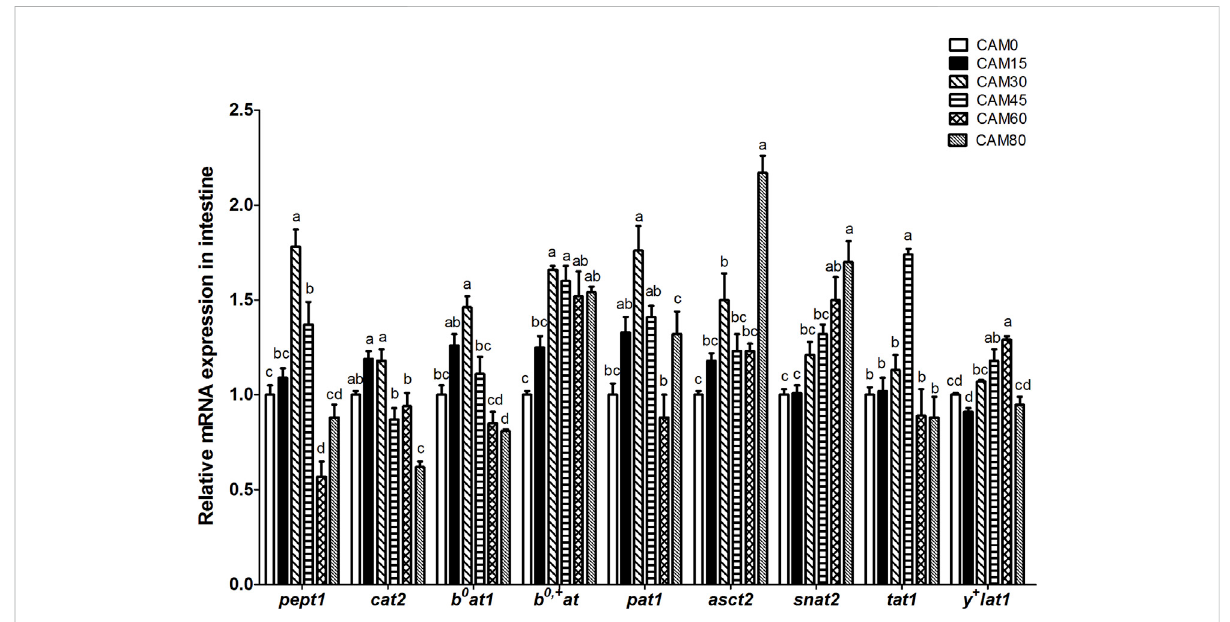
FIGURE 2 RelativemRNAexpressionofpeptideandaminoacidstransportersinintestineofturbotfeddifferentdiets.Dataarepresentedasmeans±S.E.M ( n = 3). Columns sharing the same superscript letter or absence of superscripts are not signi fi cantly different determined by Tukey ’ s test ( p > 0.05). Transcriptional levels were normalized by the reference gene of RNA polymerase II subunit D ( rpsd ). pept1 , peptide transporter 1; cat2 , cationic amino acid transporter 2; b 0 at1 , B 0 -type amino acid transporter 1; b 0,+ at , b 0,+ -type amino acid transporter; pat1 , proton-coupled amino acid transporter 1; asct2 , system ASC amino acid transporter-2; snat2 , sodium-coupled neutral amino acid transporter 2; tat1 , T-type amino acid transporter1; y + lat1 ,systemy + Laminoacidtransporter1.Polynomialcontrastsanalysis: pept1 : P value =0.000, P Linear =0.354, P Quadratic =0.000; cat2 :